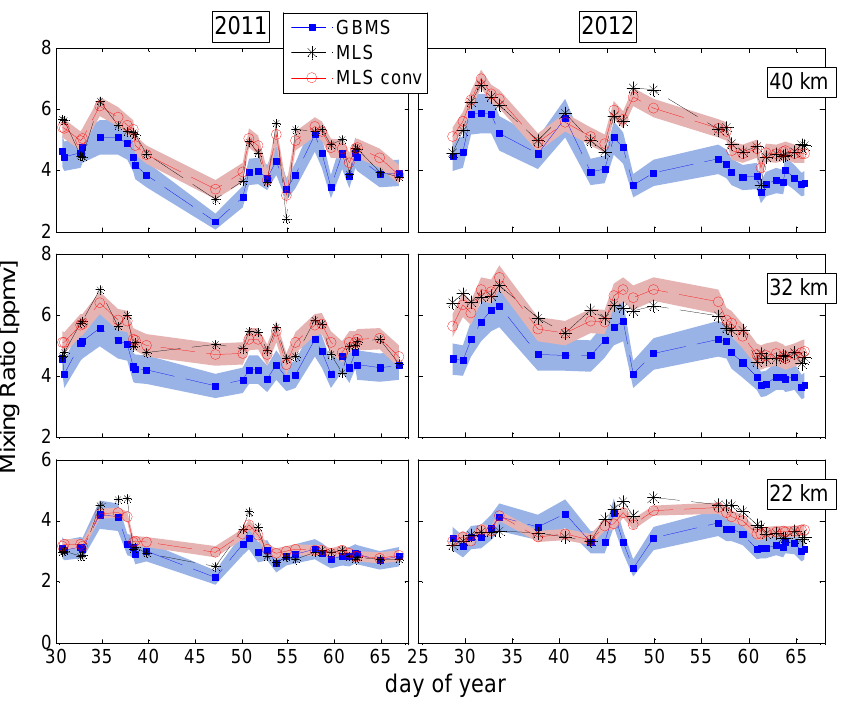
Fig. 4. Timeseries of GBMS (blue squares), Aura MLS (black stars) and convolved Aura MLS (open red circles) O 3 data for 2011 (left panels) and 2012 (right panels) at three altitude levels: 22km, 32km and 40km. The blue shaded area depicts the GBMS uncertainty, calculated as described in Sect. 3.1 and shown in Fig. 1. Uncertainties on the convolved MLS data (red shaded area) include both systematic and random errors.